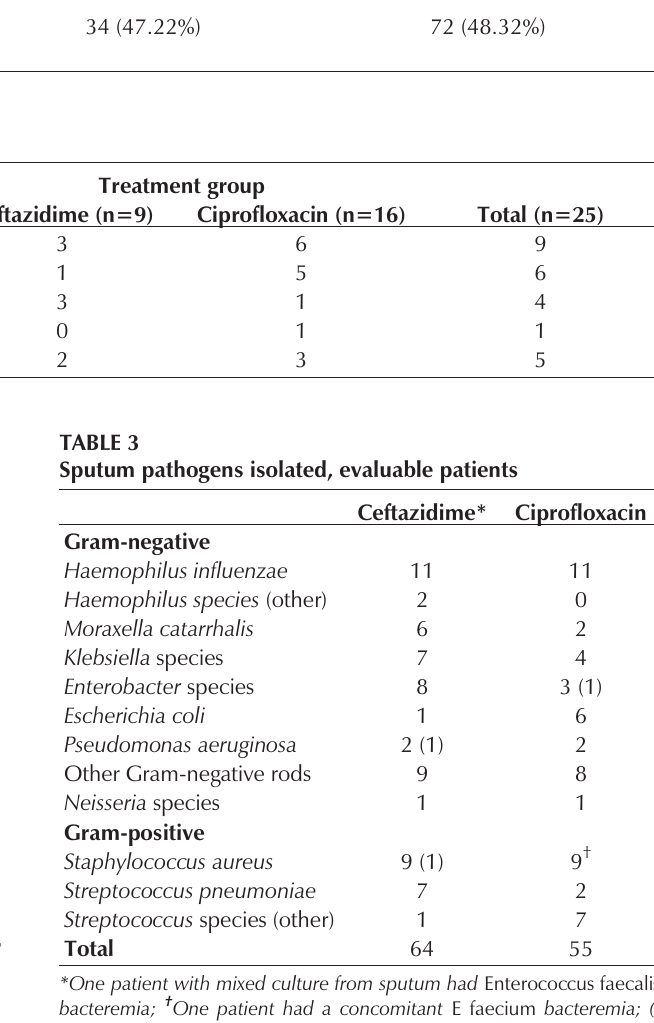
Reasons for exclusion from efficacy analysis